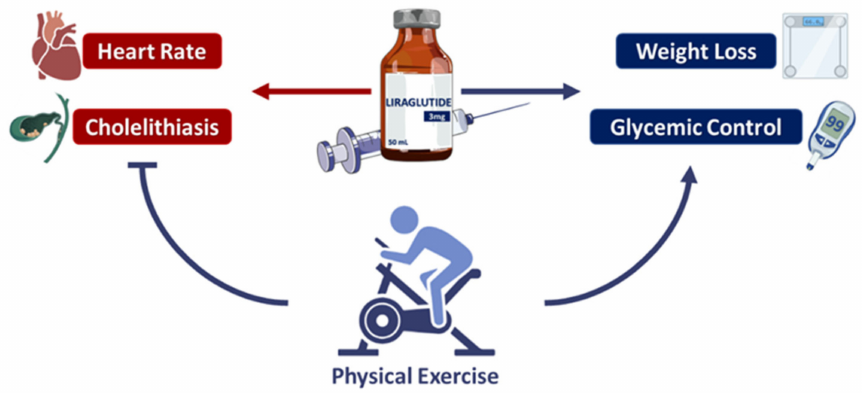
Figure 1. Summary of the effects of liraglutide associated with exercise or